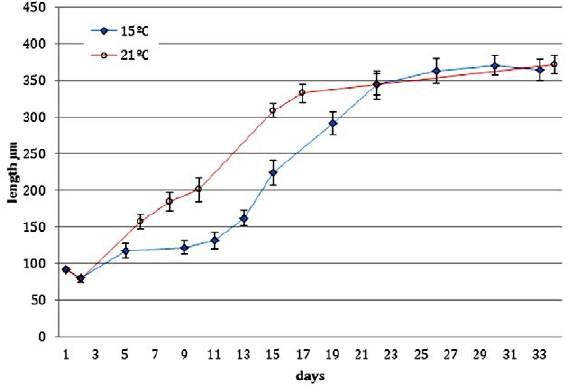
Fig. 8. – Sabellaria spinulosa. Larval growth rate at 15°C and